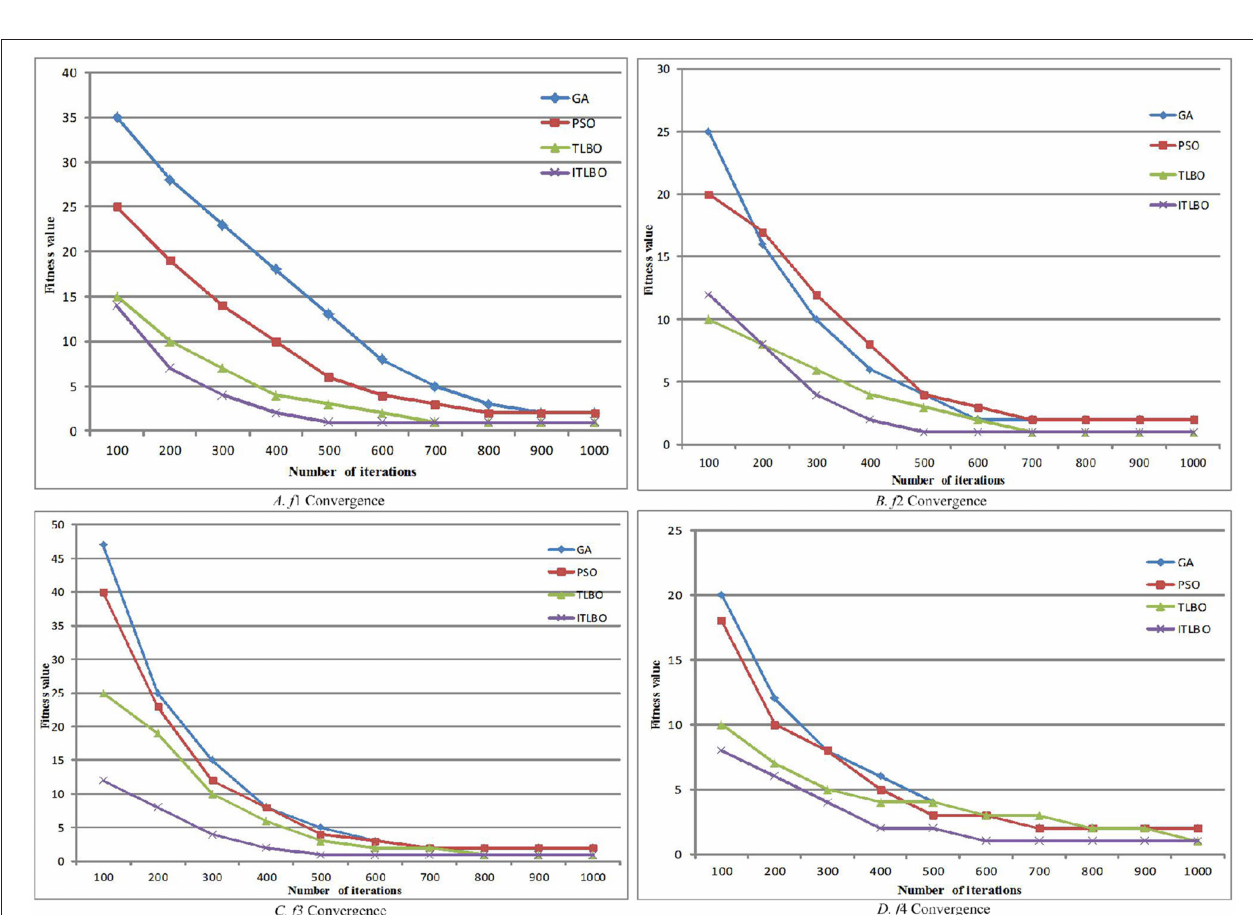
FIGURE 1 | Convergence comparison of four functions. (A) f 1 Convergence. (B) f 2 Convergence. (C) f 3 Convergence. (D) f 4 Convergence.